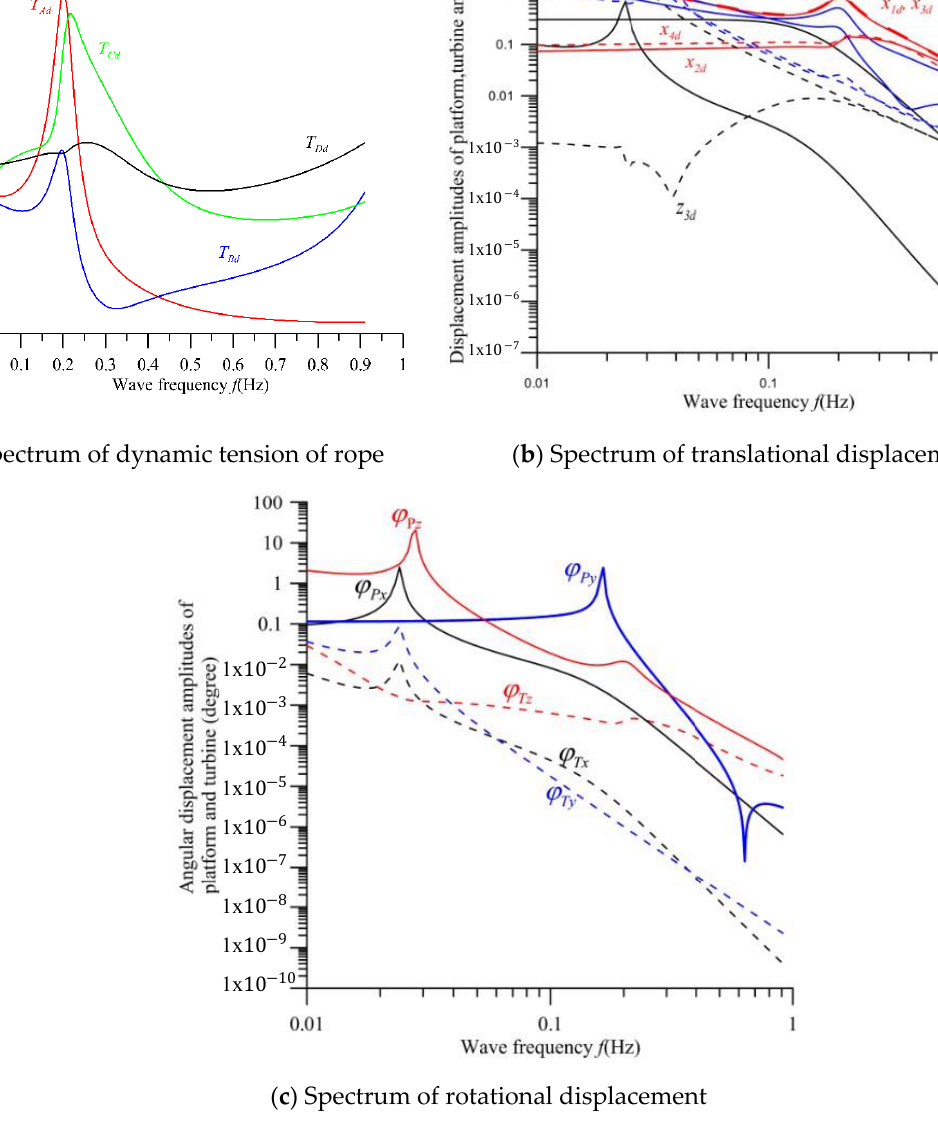
Figure 15. Spectrums of displacement and tension ( L C = 60 m, L D = 140 m P T 1 = = ).